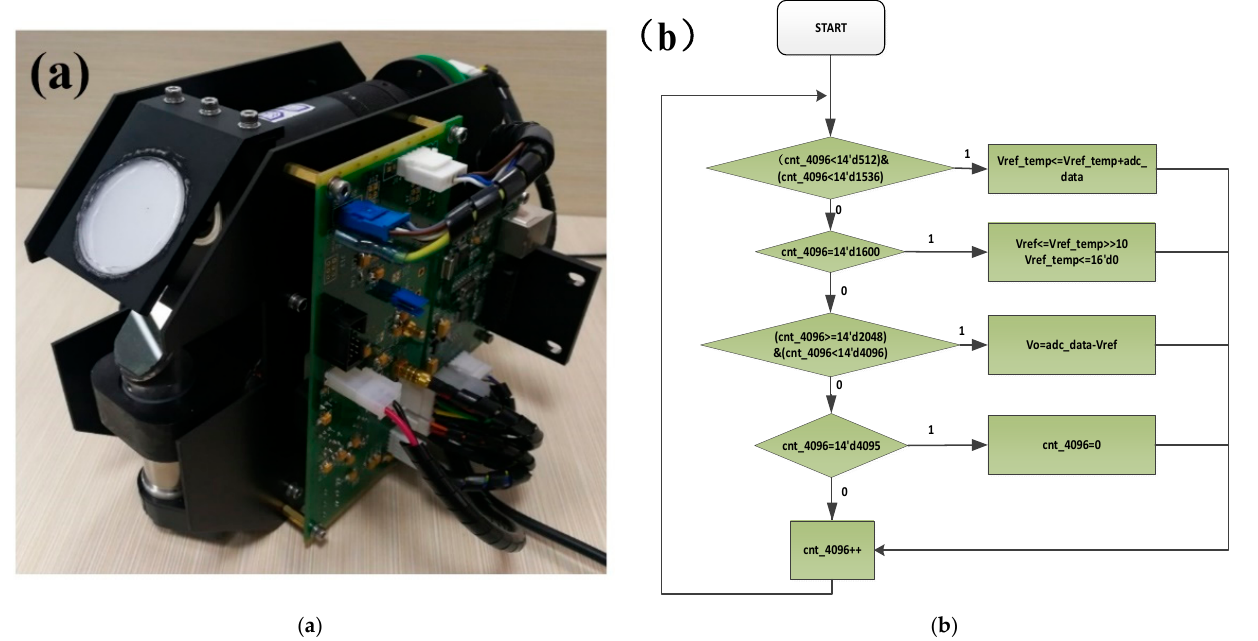
Figure 3. ( a ) Infrared scanner, ( b ) FPGA-based digital signal processing with inner blackbody compensation. Table 1. Key technical index of infrared scanner.